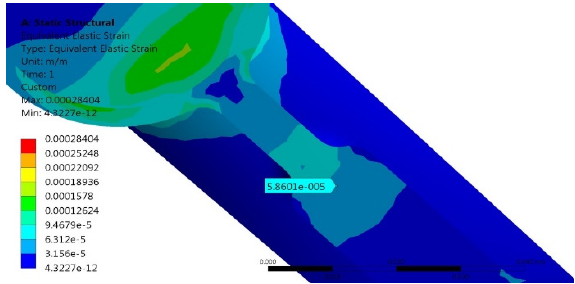
Figure 23. Measurement of strain using FEA.